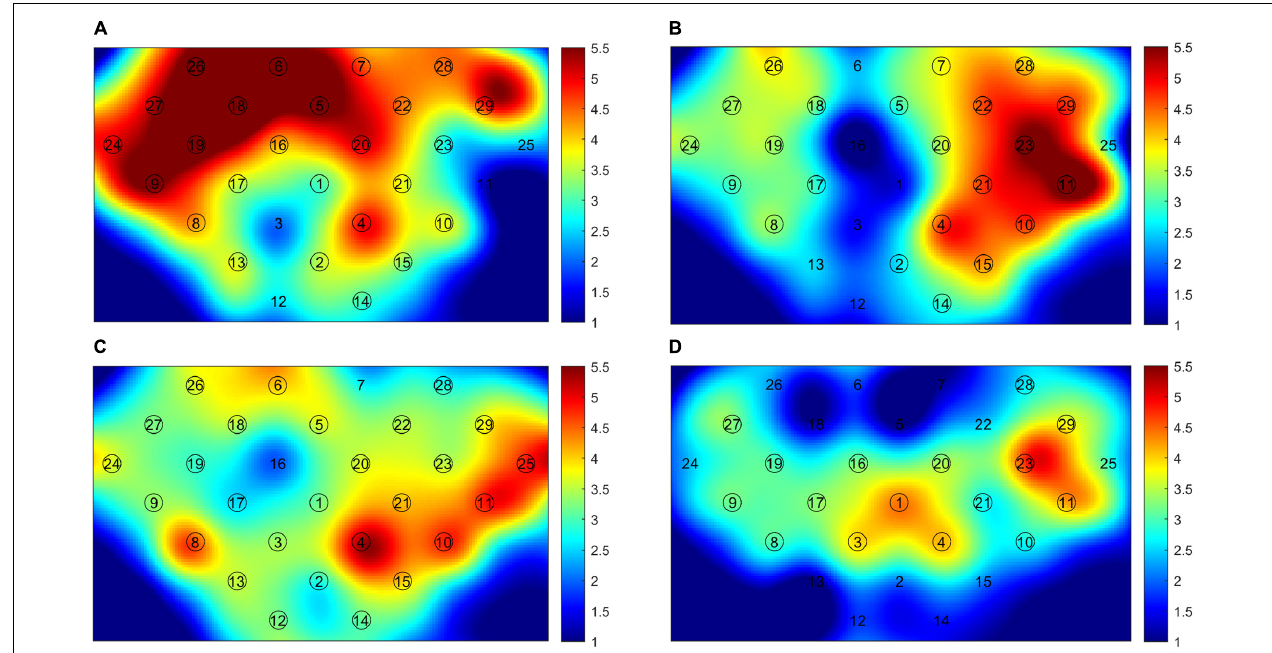
FIGURE 2 | The cerebral cortex activation map. (A) Right-hand task of healthy subjects (HS); (B) left-hand task of HS; (C) right-hand task of left hemisphere stroke (LHS) patients; (D) left-hand task of right hemisphere stroke (RHS) patients. The circled channels are significantly activated channels.